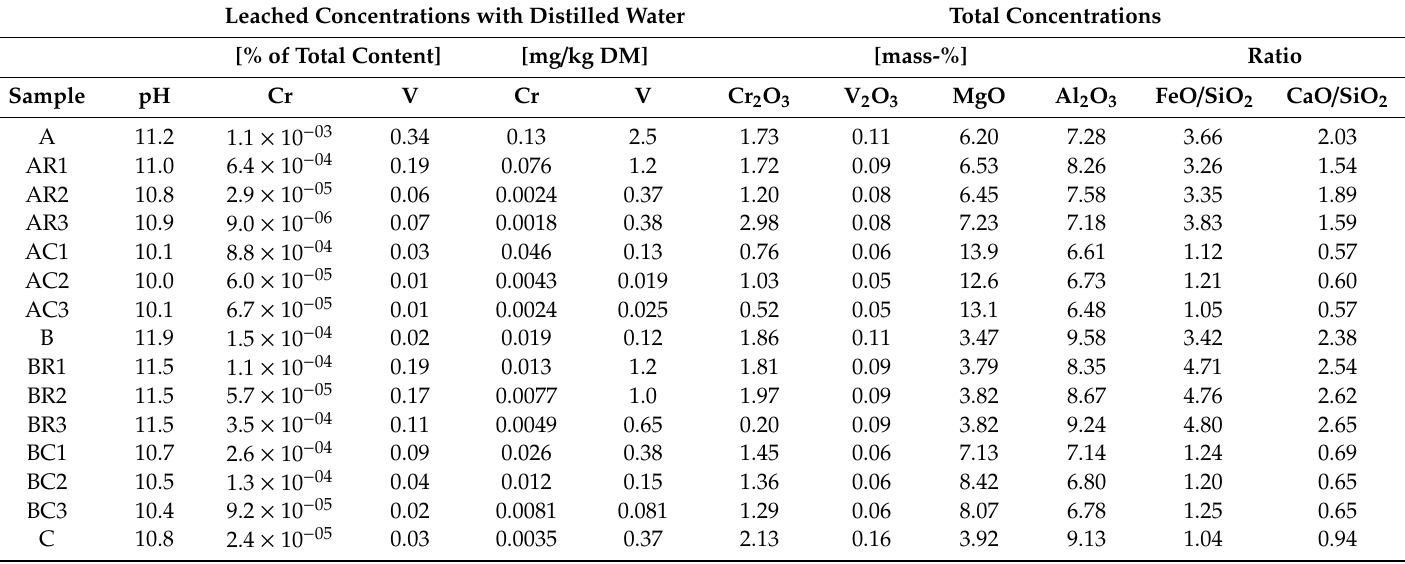
Table 1. Leached concentrations of V and Cr at natural pH (shaken with distilled water) for original samples A, B, and C as well as for remelted samples AR1–3 and BR1–3 and remelted, modified samples AC1–3 and BC1–3. Total concentrations of Cr 2 O 3 , V 2 O 3 , MgO, and Al 2 O 3 as well as ratios of FeO / SiO 2 and CaO / SiO 2